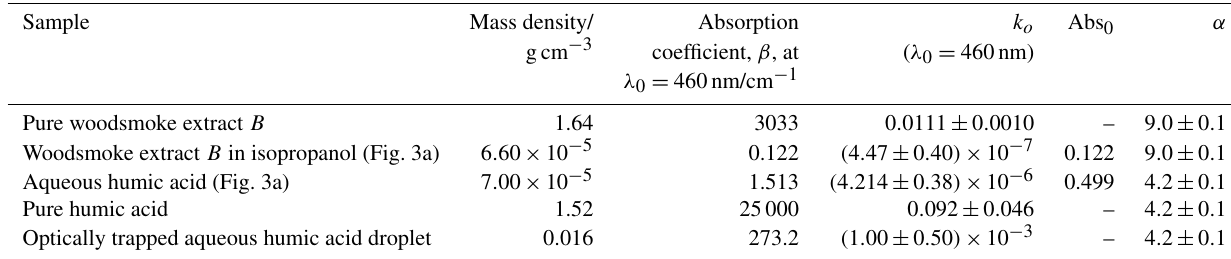
Figure 2. Typical Mie spectra for the woodsmoke aerosol extract B and the humic acid aerosol with simulated Mie spectra with and without absorption. The simulated Mie spectra when the measured absorption Ångström exponent, α , was included or when the absorption Ångström exponent was held at zero are shown for woodsmoke aerosol extract and humic acid aerosol. Note the absorption measured in Fig. 3 is required to provide a good fit to the intensity of the data, especially at short wavelengths. Table 2. The mass densities and absorption properties of the woodsmoke and humic acid samples used in the work described here. Note that the mass densities of the woodsmoke extract in isopropanol and aqueous humic acid solutions refer to the mass of either woodsmoke extract or humic acid in the volume of isopropanol or water respectively and are not the mass densities of the pure compounds which are also reported in the